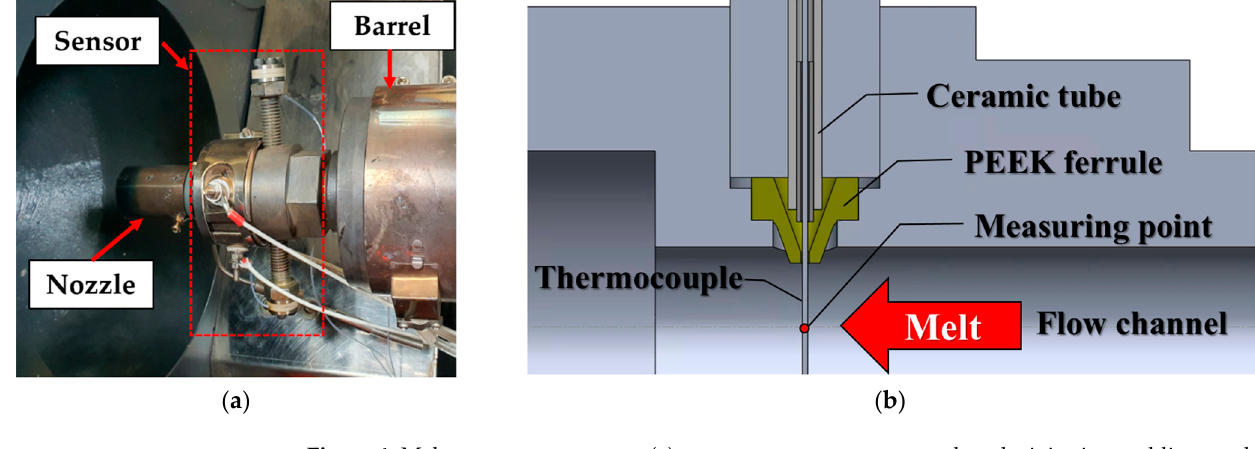
Figure 4. Melt temperature sensor: ( a ) temperature sensor mounted on the injection molding machine; ( b ) internal detailed structure .